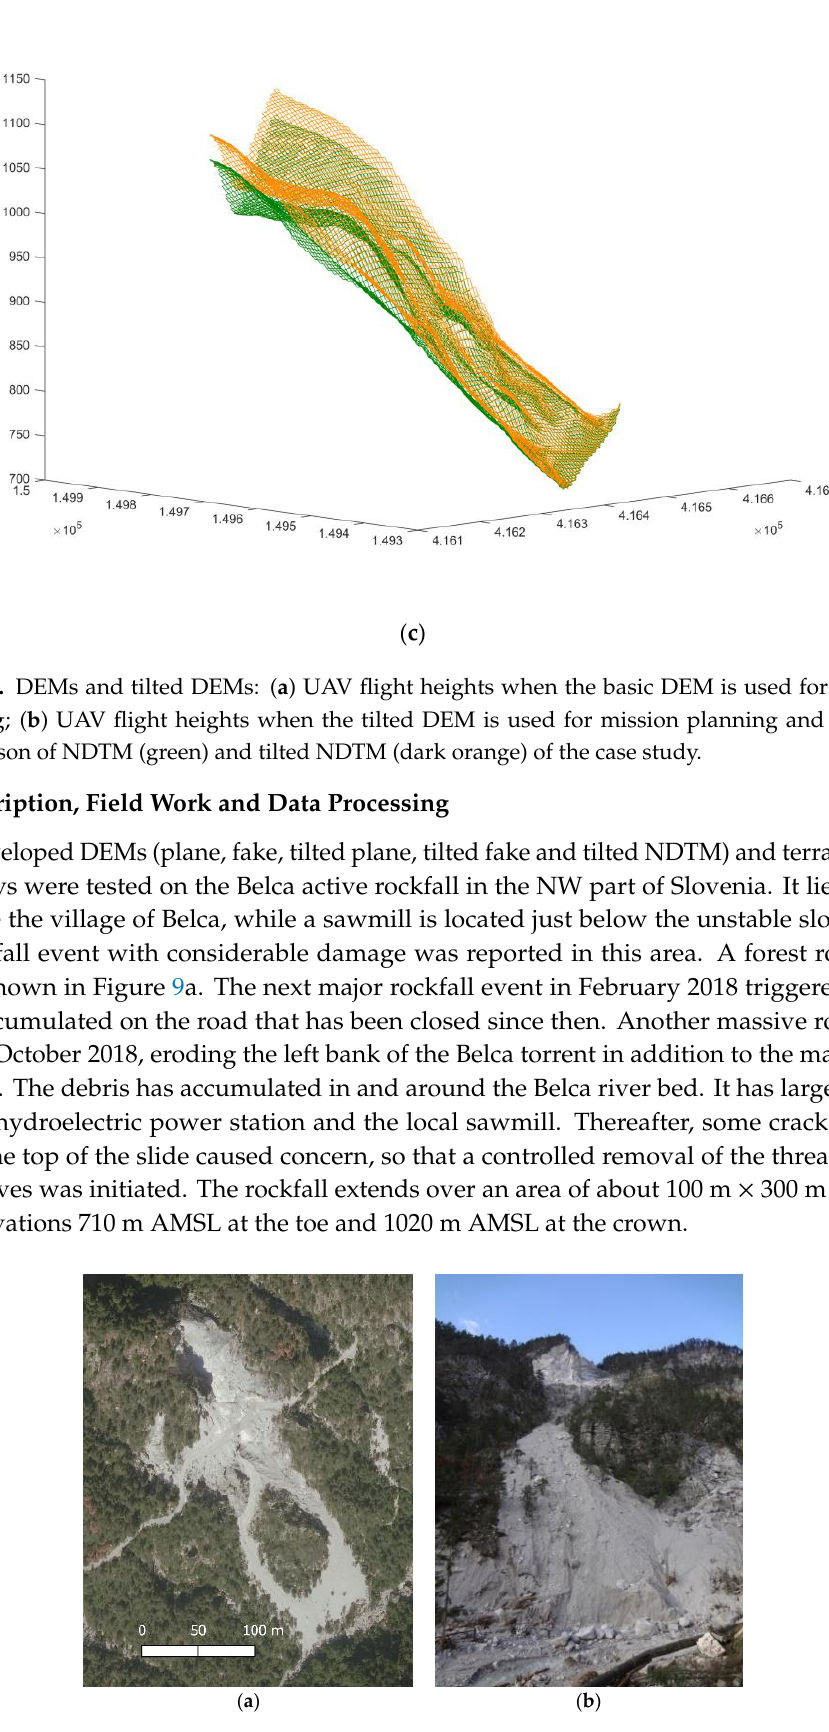
Figure 9. Belca rockfall: ( a ) on the national orthophoto and ( b ) on a photograph taken at the bottom. In the period from November to December 2018, several UAV surveys were carried out in which different DEMs and types of images were tested. Table 1 shows an overview of the surveys. Table 1. Surveys of the Belca rockfall with information on DEMs and the type of images used in each mission.